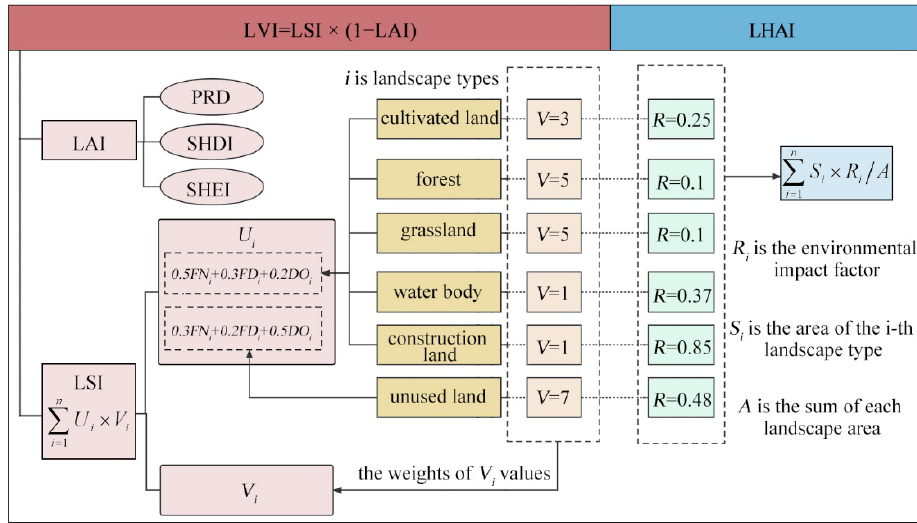
Figure 2. Flowchart for calculating LVI and LHAI.